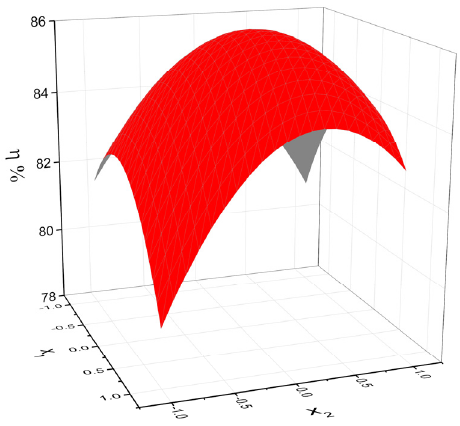
Figure 2. Yield map obtained for molecule IX.